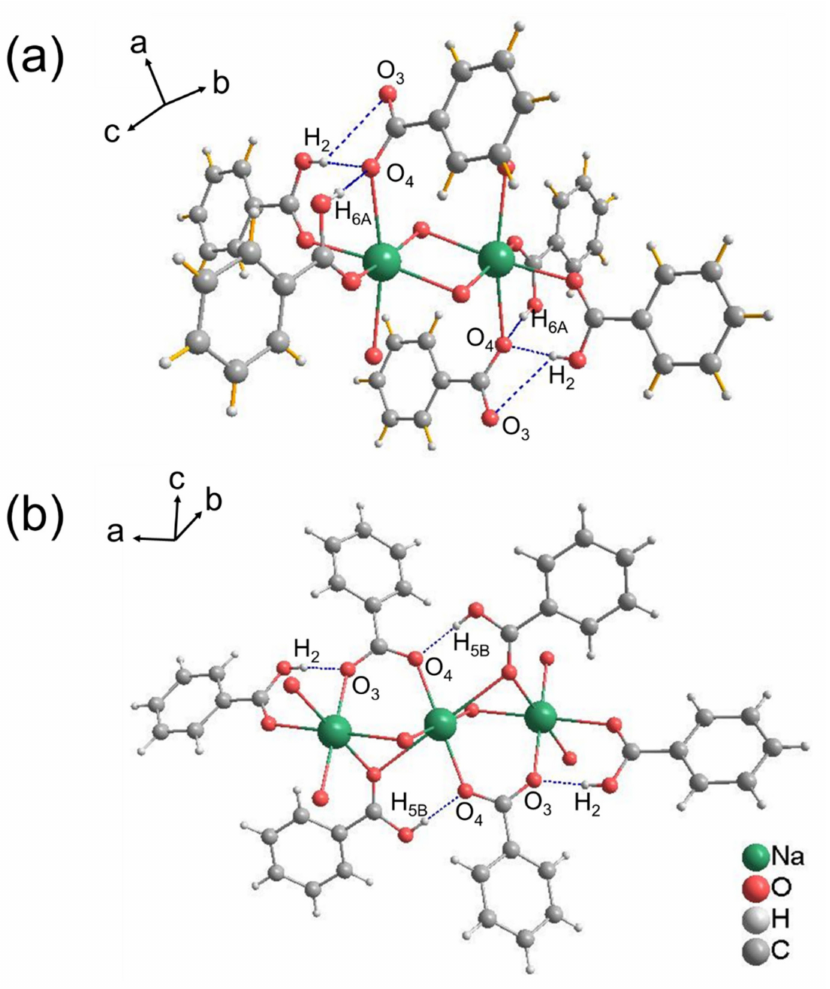
Figure 2. Illustration of intermolecular interactions of 2:1 co-crystal of HBz–NaBz: ( a ) Form I and ( b ) Form II. Some carboxylic/carboxylate ligands of sodium atoms are omitted for